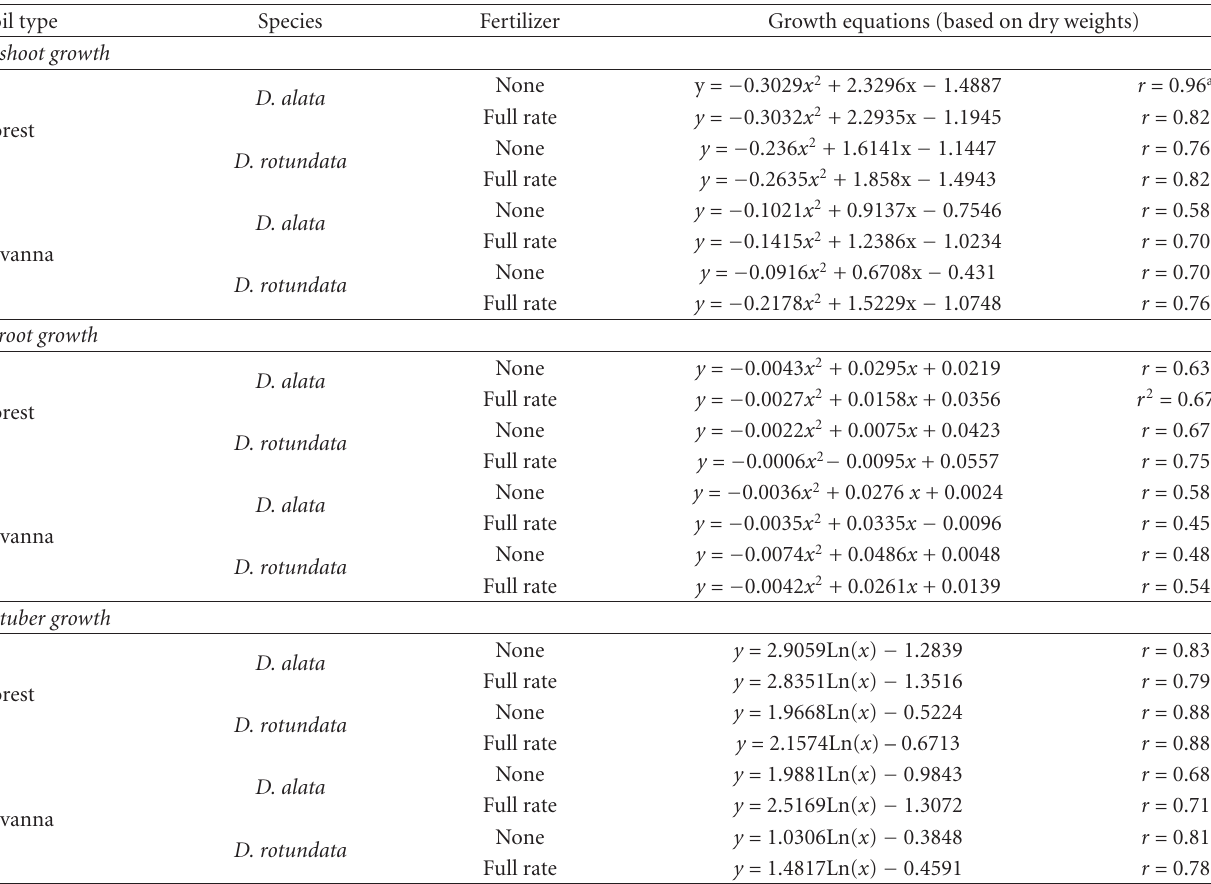
Table 2: Shoot, root, and tuber growth of Dioscorea spp. as a ff ected by soil type and fertilizers ( x : days after planting; y : dry matter in the considered organ; n : 28 for D. alata , and n : 24 for D. rotundata ).